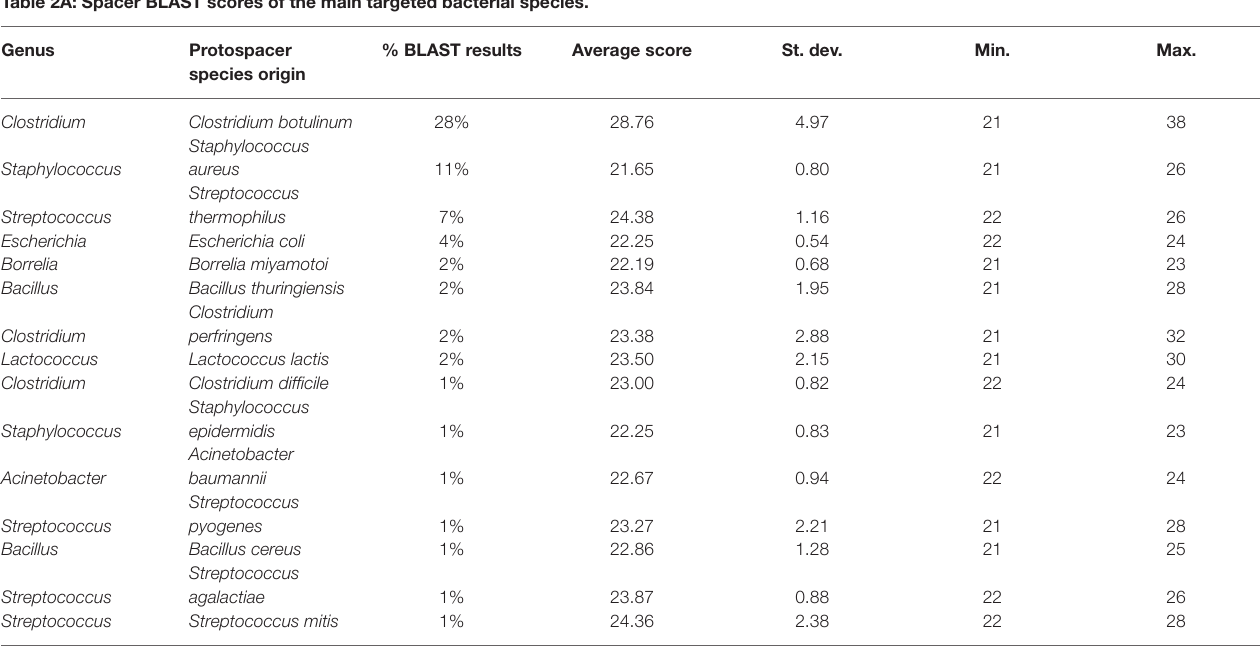
TABLE 2 | The score value represents the percentage of homology between the spacer and its target (Biswas et al., 2013). Table 2A: Spacer BLAST scores of the main targeted bacterial species.